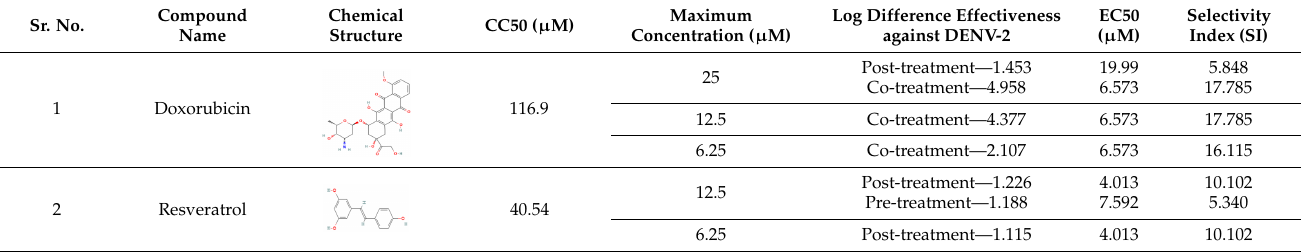
Figure 3. Antiviral screening of drugs for repurposing at maximal nontoxic concentration against DENV under ( a ) pre-, ( b ) post-, and ( c ) co-treatment conditions. Vero CCL-81 cells were treated with a maximum non-toxic dose of drugs for 24 h in a pre-, co-, and post-infection manner and incubated for 120 h with DENV. Post incubation, plates were frozen and culture filtrates were used for different assays. Experiments were performed in triplicate in two independent trials. Results were plotted based on mean log10 of focus-forming unit/mL ± standard error. All the treatment groups were compared with a control group (VC) (infected cells without treatment). **** p < 0.0001, * p < 0.05. Table 2. Summary of effective inhibition under different treatment conditions.